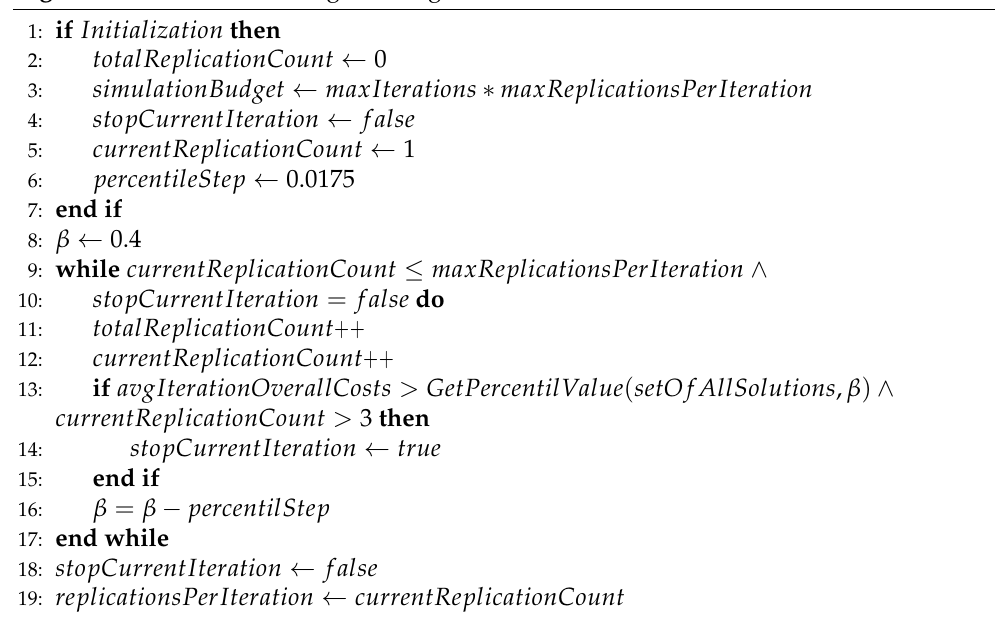
Algorithm 3 Simulation budget